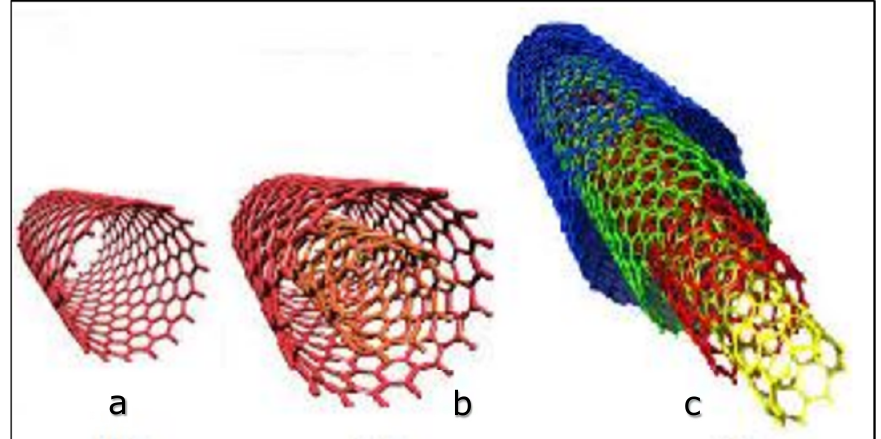
Figure 2. Types of carbon nanotubes: single-walled carbon nanotube (SWCNTs ( a )), double-walled carbon nanotube (DWCNTs ( b )) and multiple-walled carbon nanotube (MWCNTs ( c )) [94].